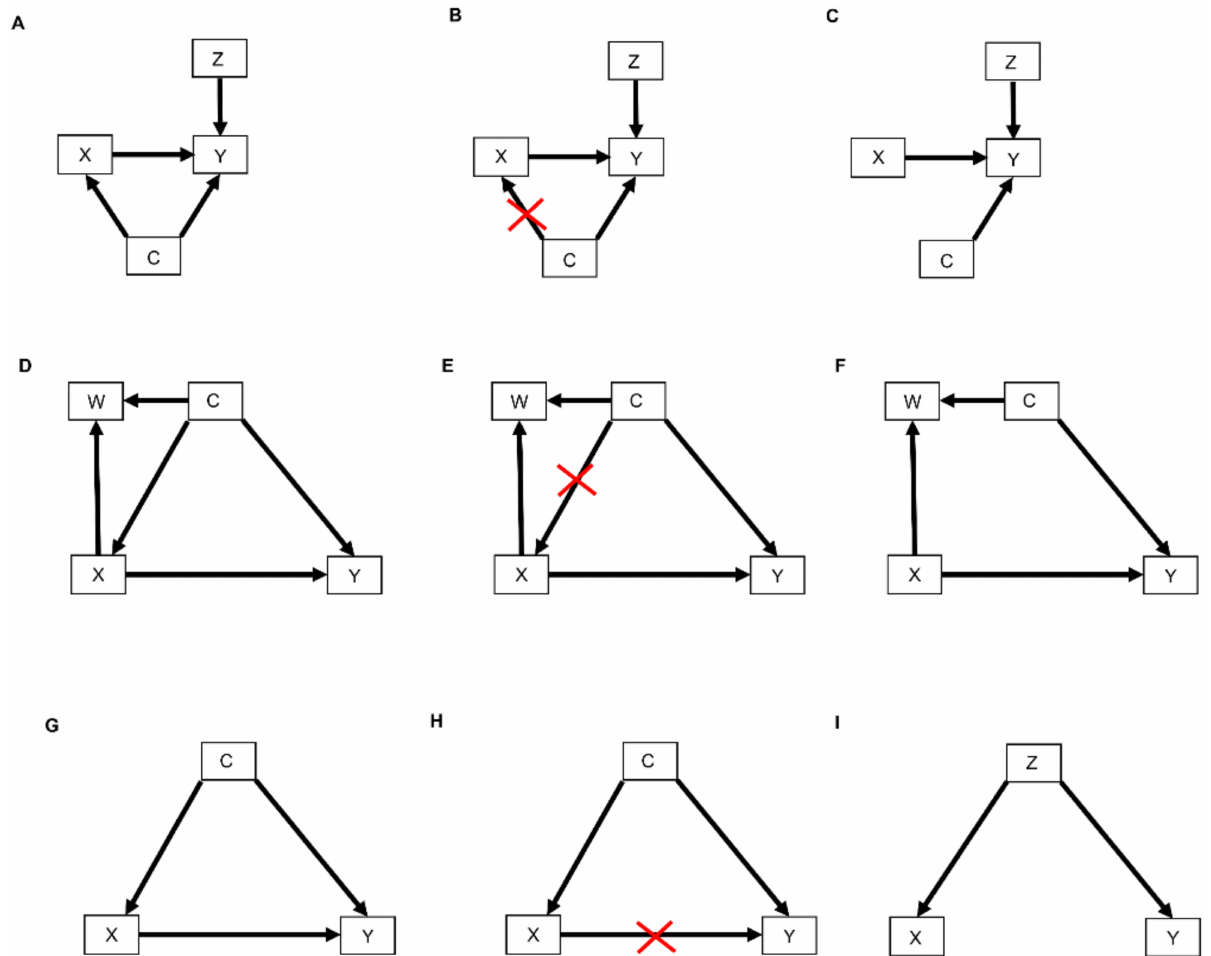
Figure 4. DAGs modified by the do() operator: ( A ) Treatment choice X influences the outcome Y which is also influenced by covariates Z. Furthermore, unknown confounders C may influence both treatment choice X and the outcome Y; ( B ) As indicated by the red crossmarks, the do() operator expression do(X = x) removes all arrows entering X. This modification represents the physical effect of an experimental intervention that sets the value X = x as constant while keeping the rest of the causal model unchanged; ( C ) This yields a new DAG whereby the distribution P(Y | do(X = x), Z) is the same as P(Y | X = x, Z); ( D ) In this DAG, treatment choice X influences the outcome Y and another covariate W. The confounder C influences X, Y, and W; ( E ) The do() operator expression do(X = x) removes all arrows entering X; ( F ) This yields a new DAG whereby the distribution P(Y | do(X = x), C) is the same as P(Y | X = x, C); ( G ) The confounder C influences the treatment choice X and the outcome Y; ( H ) Paths from X to Y that remain after removing all arrows pointing out of X are called “backdoor” paths because they flow backward out of X into Y. Shown here is the backdoor path from X to Y via the confounder C; ( I ) In this DAG, there are no forward-directed arrows